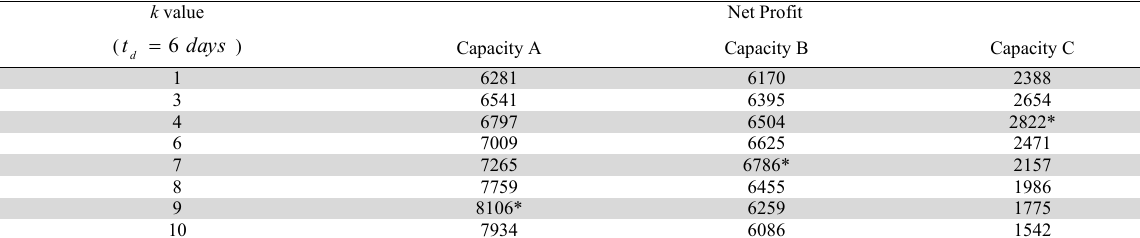
Sensitivity analysis on parameter k